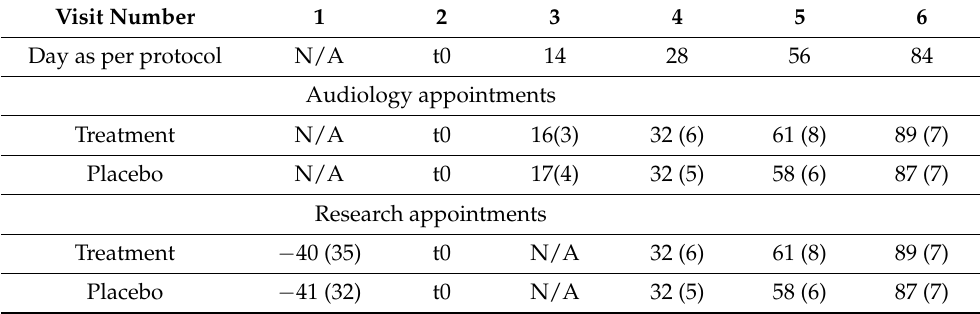
Table 4. Fidelity of audiology and research appointments in the RCT. Audiology appointments were for clinical assessment and follow-up. Research appointments were restricted to outcome assessments. Fidelity is calculated relative to the initial device fitting (visit 2), with visit 6 at 12 weeks after initial device fitting. Mean across participants in days; standard deviation in